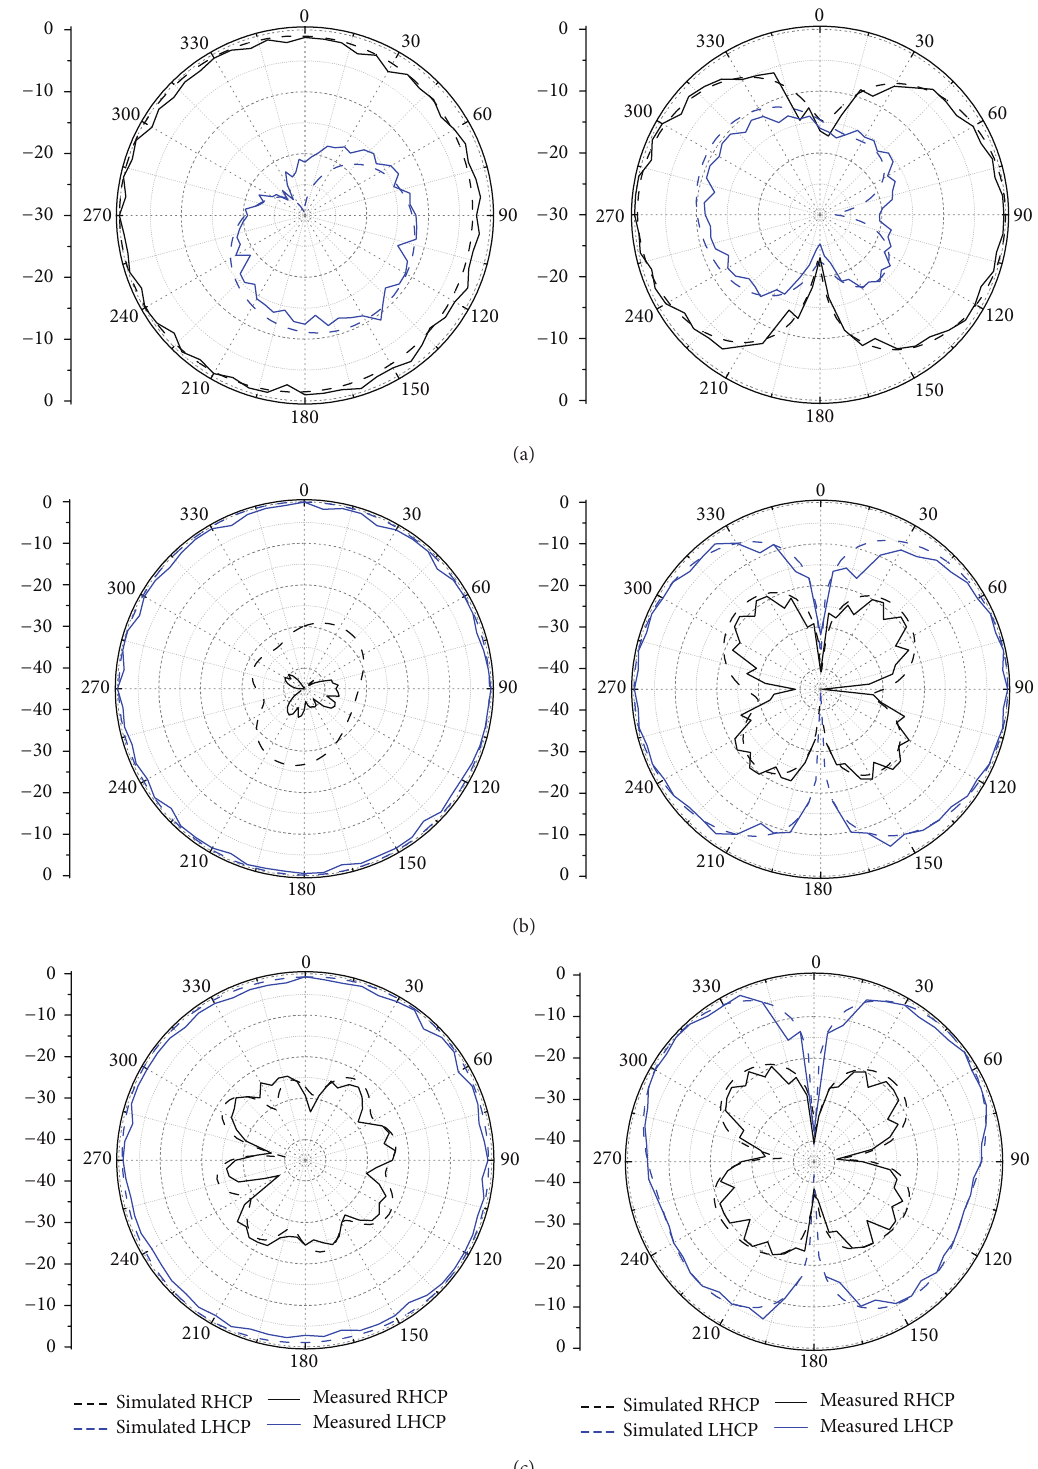
Figure 7: Simulated and measured radiation patterns in the azimuth plane (left) and the elevation plane (right). (a) 1.937 GHz. (b) 2.45 GHz. (c) 3.51